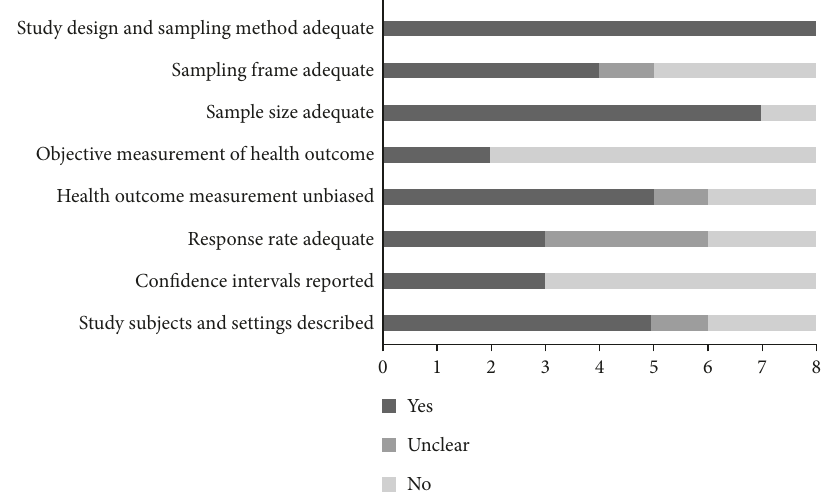
Figure 2: Summary of methodological characteristics of included studies.